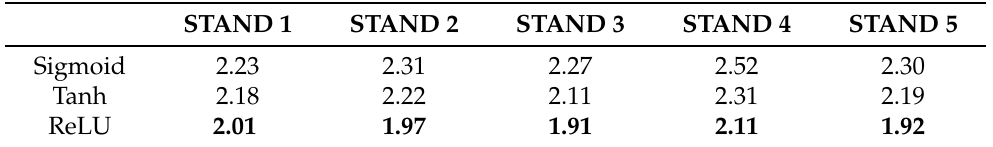
Table 2. Experimental results with various activation functions for the roll force prediction models. (The number of hidden layers: 1. The number of hidden nodes: 700. Learning rate: 0.001.)